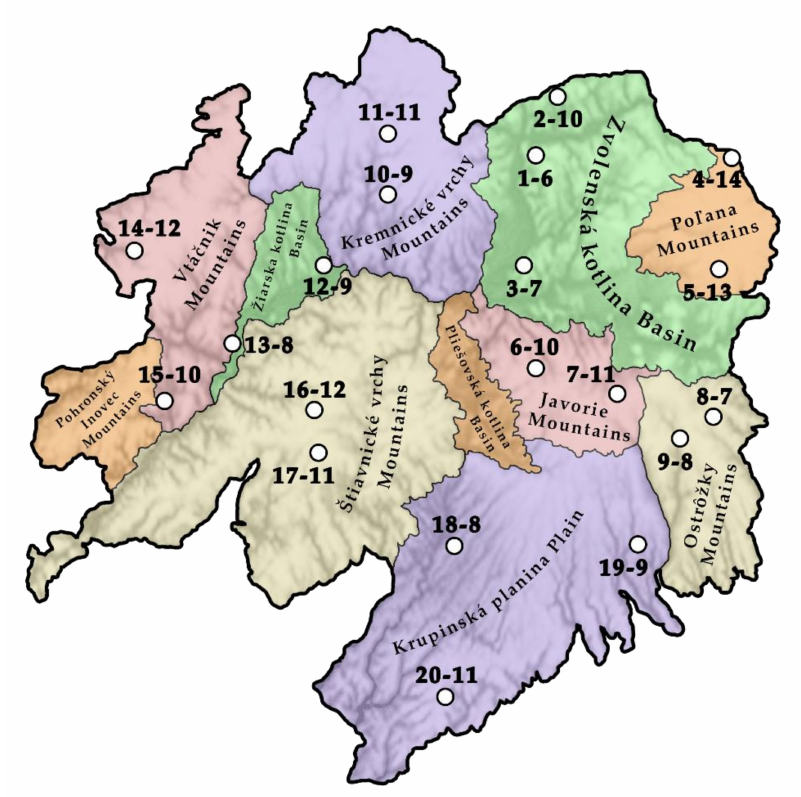
Figure 4. Distribution of potential for astrotourism development (PAD) values at selected study sites within the Slovensk é stredohorie Upland region (number of study site–PAD